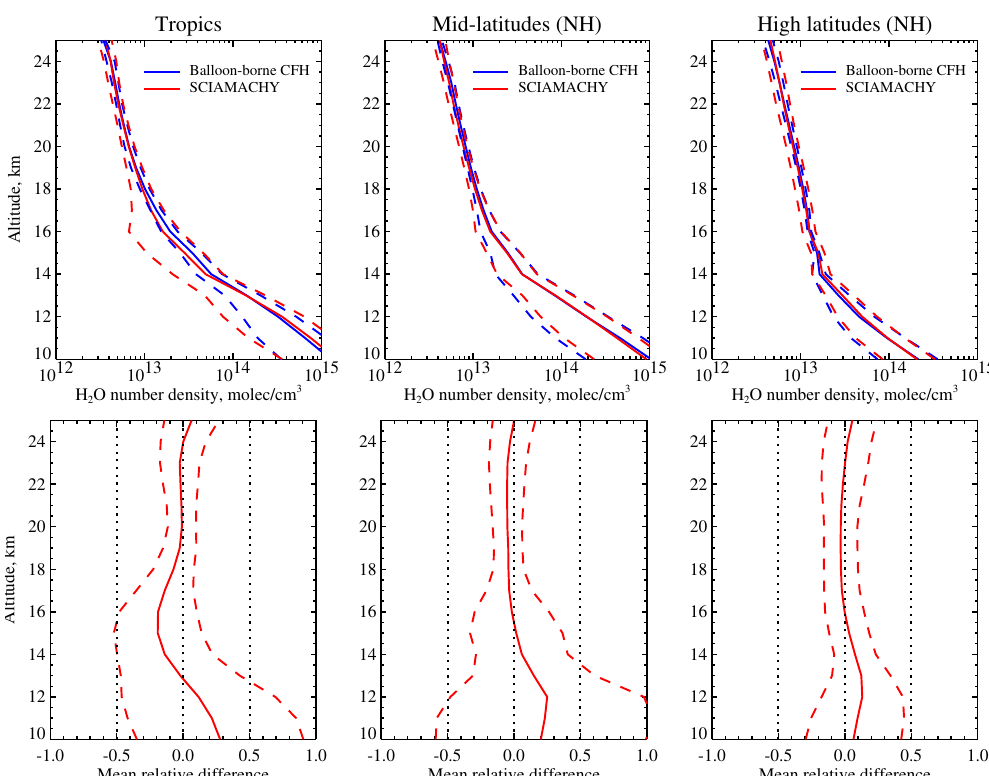
Fig. 21. Comparison to in situ balloon-borne observations for different latitudinal ranges: tropics (left), mid-latitudes of the Northern Hemisphere (middle), and high latitudes of the Northern Hemisphere (right). Upper panels show average balloon-borne CFH (blue) and SCIAMACHY (red) profiles with solid lines and corresponding standard deviations with dashed lines. Lower panels show mean relative differences between SCIAMACHY and balloon-borne CFH results (solid line) and corresponding standard deviations (dashed